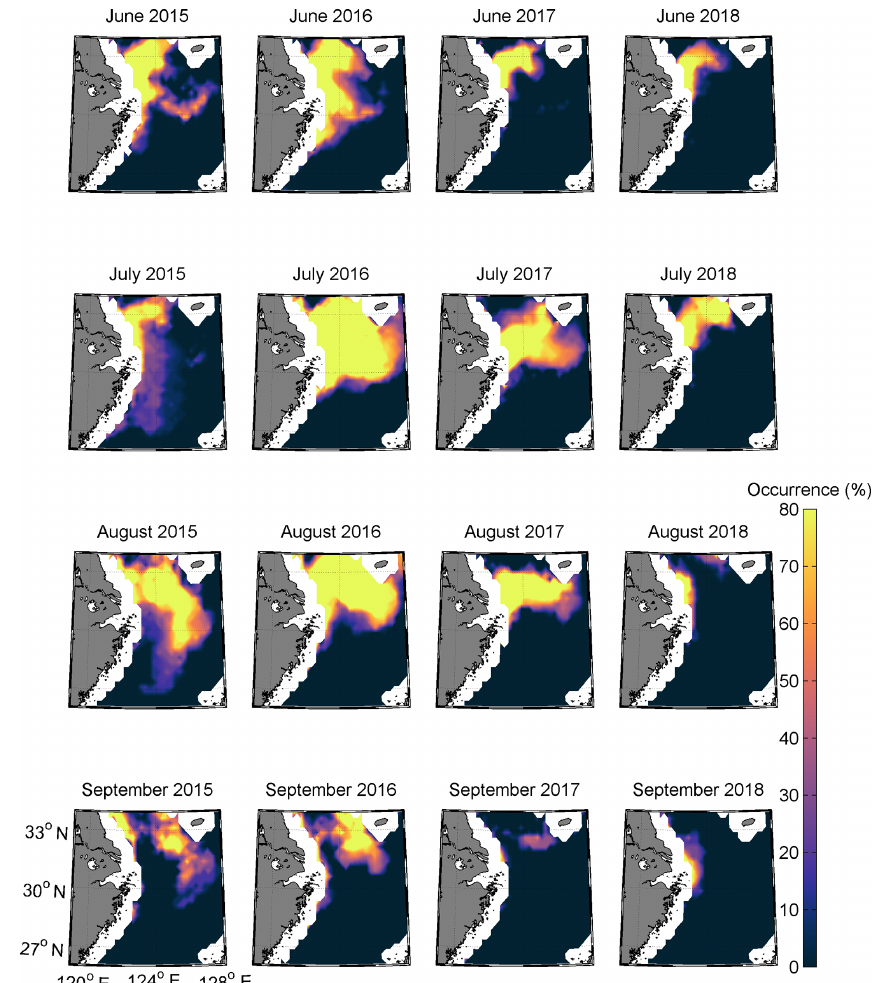
Figure 11. Maps of monthly occurrence (%) of (remotely sensed) salinity < 30 from June to September in